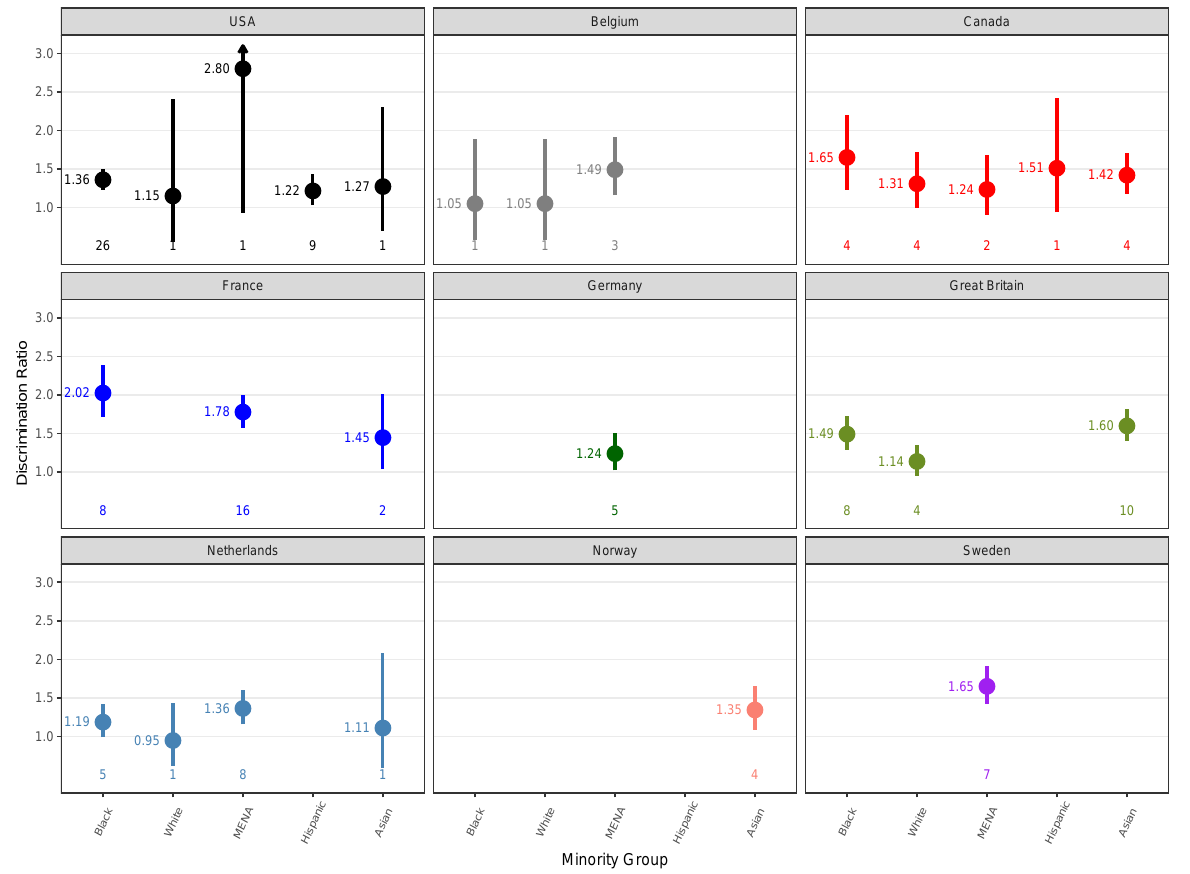
Figure 1: Average Discrimination Ratios by Country and Target Group